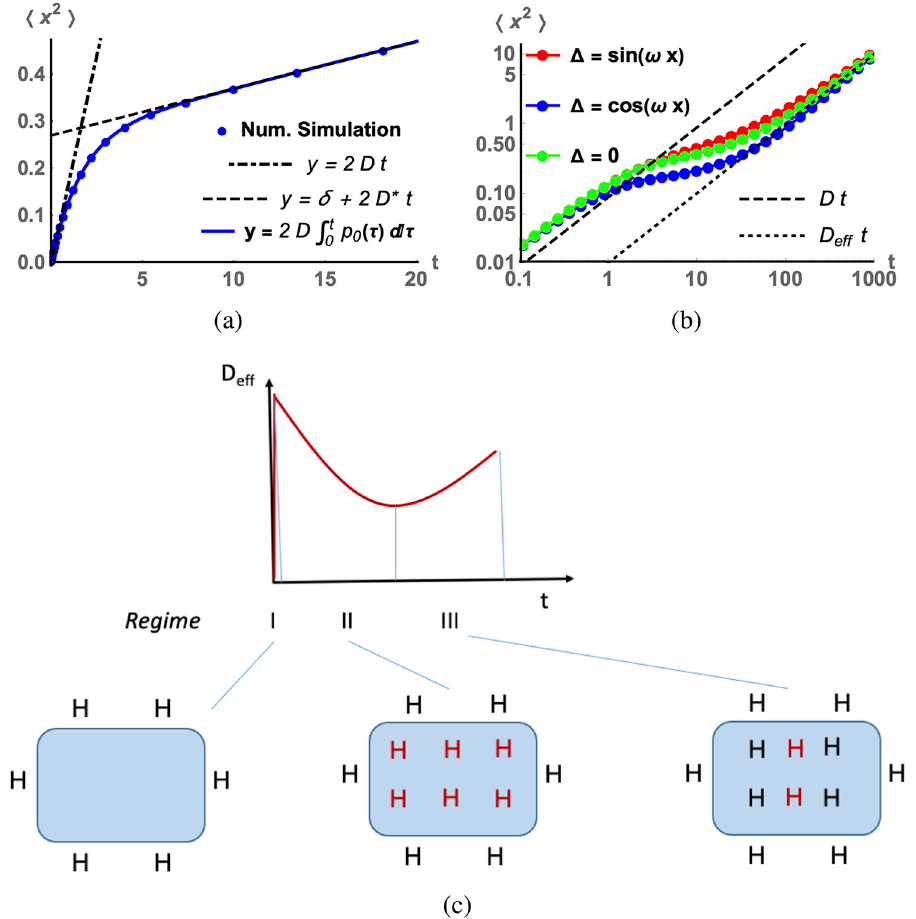
Fig 3. (a) The one-dimensional simulation of the toy model, Eqs (13)–(15). Parameter values are D = 0.088, k − = 0.035, k + = 0.58 (uniform). Offset δ has been determined from Eq (25): δ � 0.27. (b) Log-log plot of mean square displacement for non-uniform distribution of binding rate, k and perturbation Δ ( x ) is periodic with frequency o ¼ 2 p function of time for the full problem. Black H is dye bound to specific DNA binding sites and red H is dye bound to less specific, high capacity, low affinity DNA binding sites.